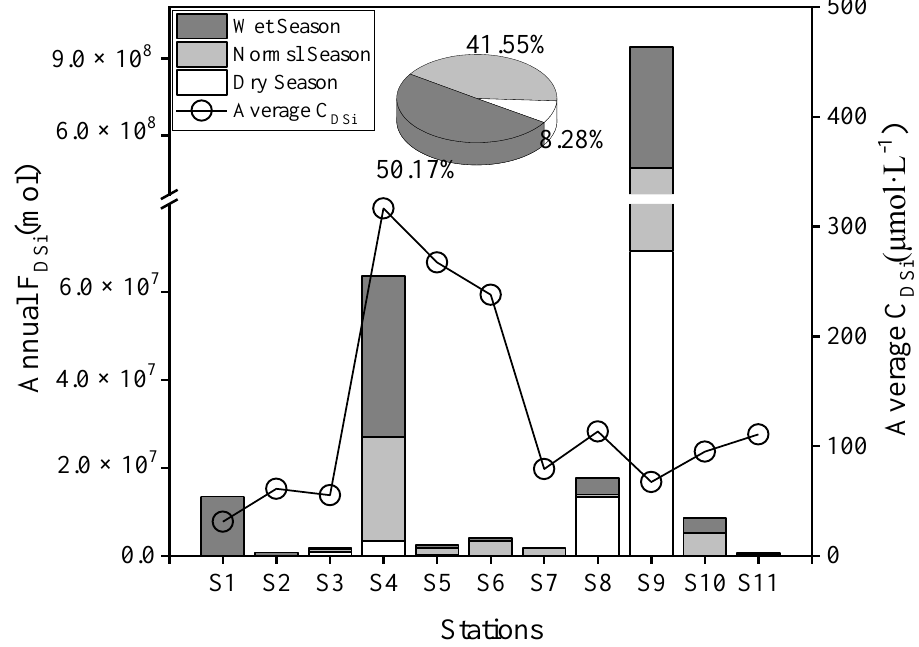
Figure 5. Annual DSi flux (F DSi ) and average DSi concentration (C DSi ) variation from the estuaries and sewage outlets of Zhanjiang Bay. The pie chart represents the seasonal proportions of F DSi .